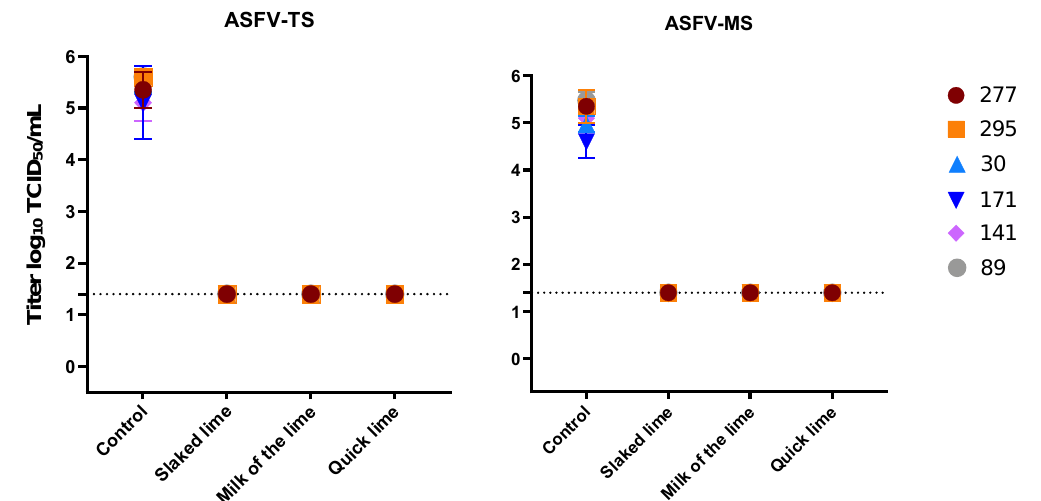
Figure 4. Disinfection of ASFV with three different types of lime in a concentration of 10%. The mean value and standard deviation of at least duplicate tests are shown. Virus titers were calculated by Spearman–Kaerber method. Limit of detection was 1.4 log 10 TCID 50 /mL.